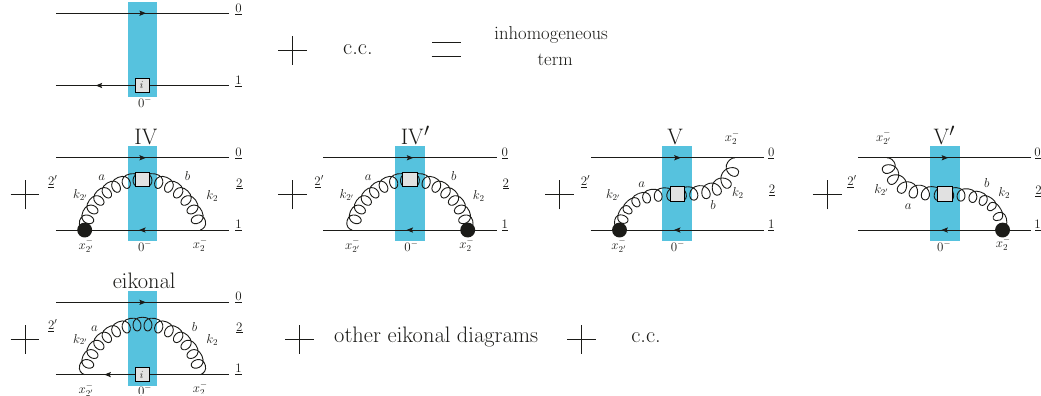
Figure 5. Diagrams representing the evolution of the polarized dipole amplitude of the second kind, G i ( zs ). Once again, the square box on the gluon and quark lines represents the sub-eikonal 10 interaction with the target given by eq. (2.10) for gluons and eq. (2.5) for quarks. The same square box, but with an i in it, on the quark line denotes the interaction described by V i G[2] black circle denotes the sub-eikonal vertex generated by the z − ∂ i A + ( z − , z ) + A i ( z − , z ) operator in through eq. (4.2). All momenta flow to the eq. ( 4.20), which contributes to G i 10